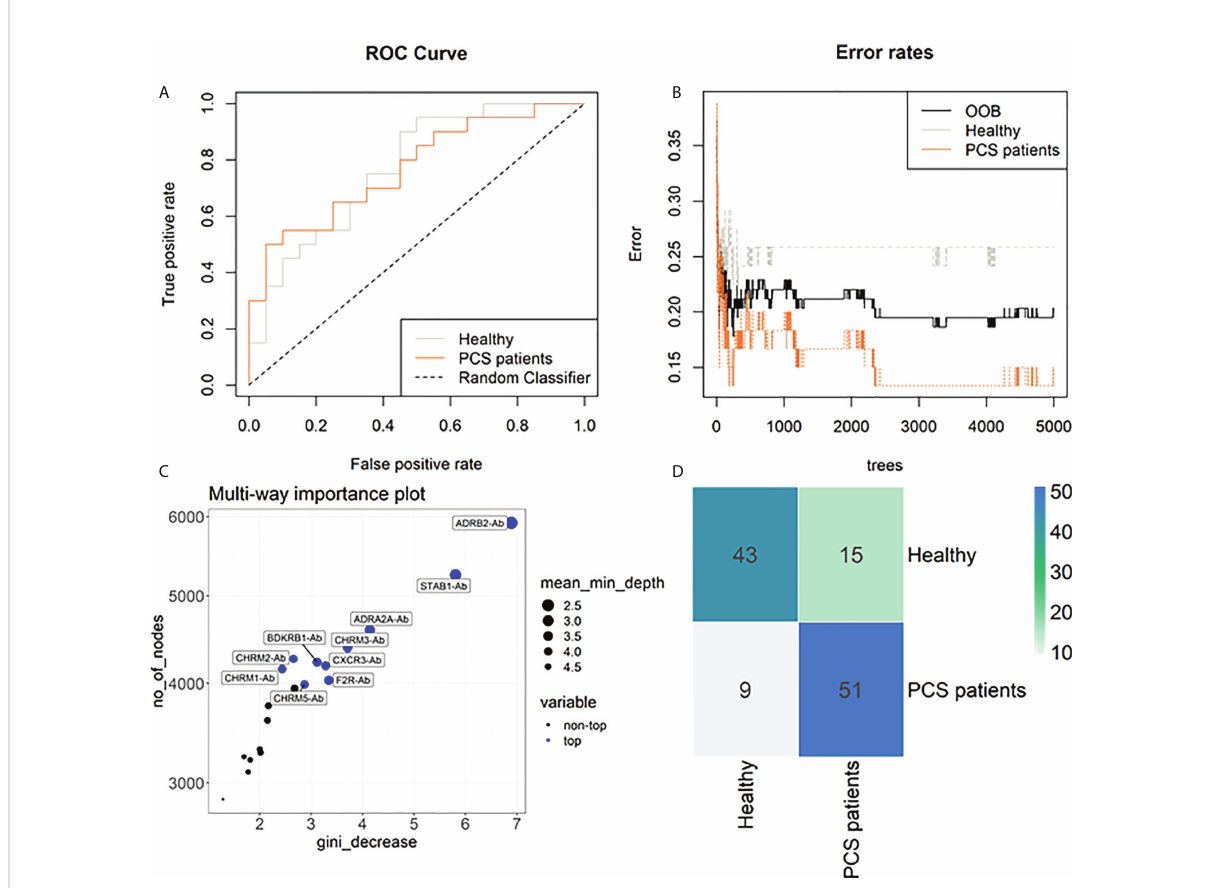
FIGURE 4 Machine learning classi fi cation of study groups based on autoantibodies. (A) Receiver operating characteristic (ROC) curves of 20 antibodies (Abs) with an area under the curve (AUC) of 77% for healthy individuals and 77% for PCS patient group. (B) Stable curve showing number of trees and out-of-bag (OOB) error rate of 20.34%. (C) Variable importance score plot based on Gini decrease and number (no) of nodes, and the mean of minimum depth for each Ab, showing which variable presents a higher score in classifying COVID-19 post-acute infection outcomes. (D) Heatmap of the confusion matrix. Numbers represent the amount of occurrences that happened when training the random forest model in predicted (row) vs actual classi fi cation (column), therefore the blueish diagonal identi fi es the hits, while other cells are